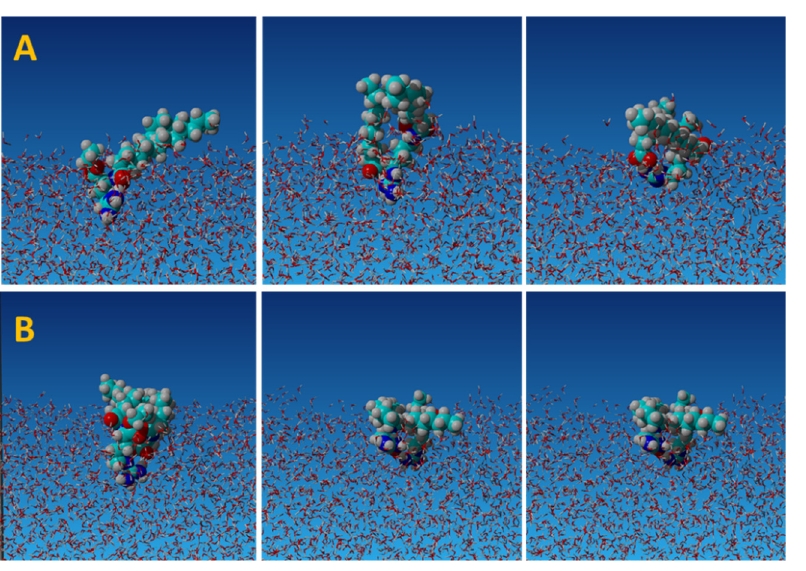
Figure 4. The examples of snapshots of molecular dynamics simulations of heterodimers at air/water interface. ( A ) LAE–dodecanoate; ( B ) LAE-LAS. Light blue, carbon; white, hydrogen; red, oxygen; blue, nitrogen.